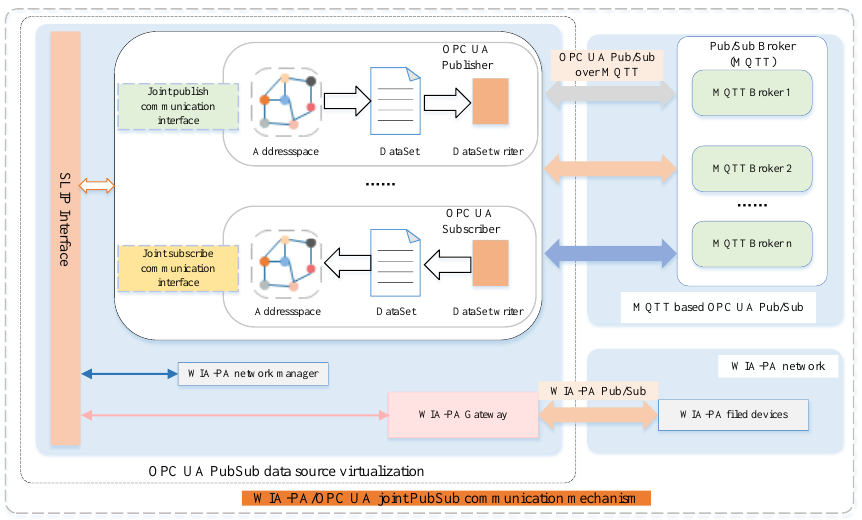
Figure 5. WIA-PA/OPC UA pub/sub software architecture.